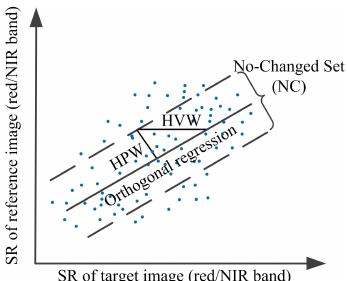
Figure 1. Determine the No-Change set (NC) from the